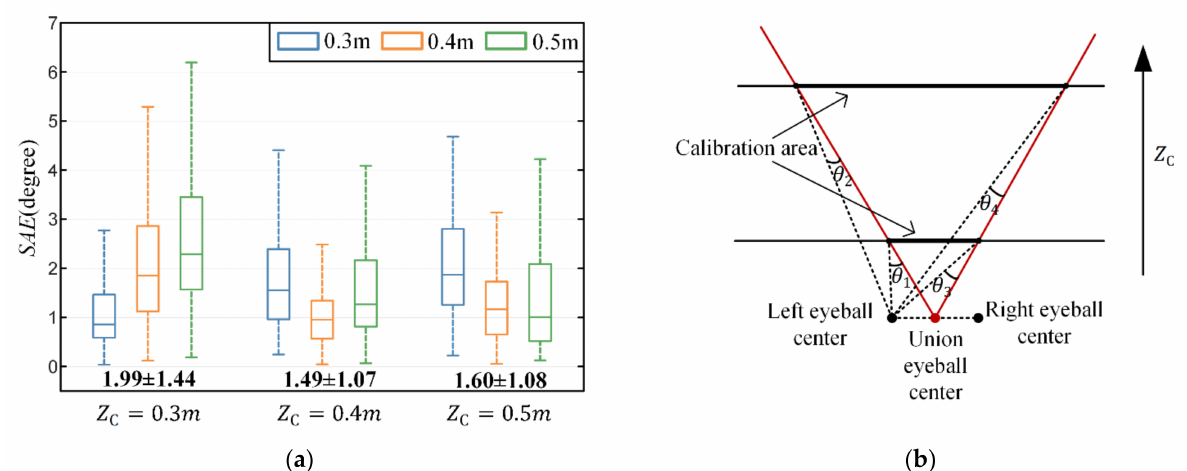
Figure 7. Gaze estimation performance of the primary calibration method. ( a ) Gaze estimation performance based on training set at different depths. Z c denotes the depth of the calibration plane. The bold black numbers at the bottom are the angular error in degrees (mean ± standard deviation).